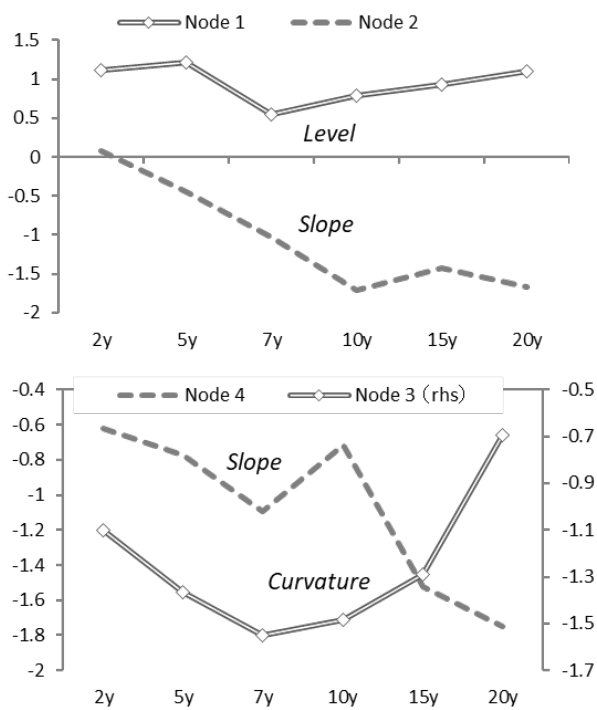
ffi cients of the linear function output from the hidden layer with four Figure 11. Coefficients of the linear function output from the hidden layer with four nodes. Figure 11. Coe